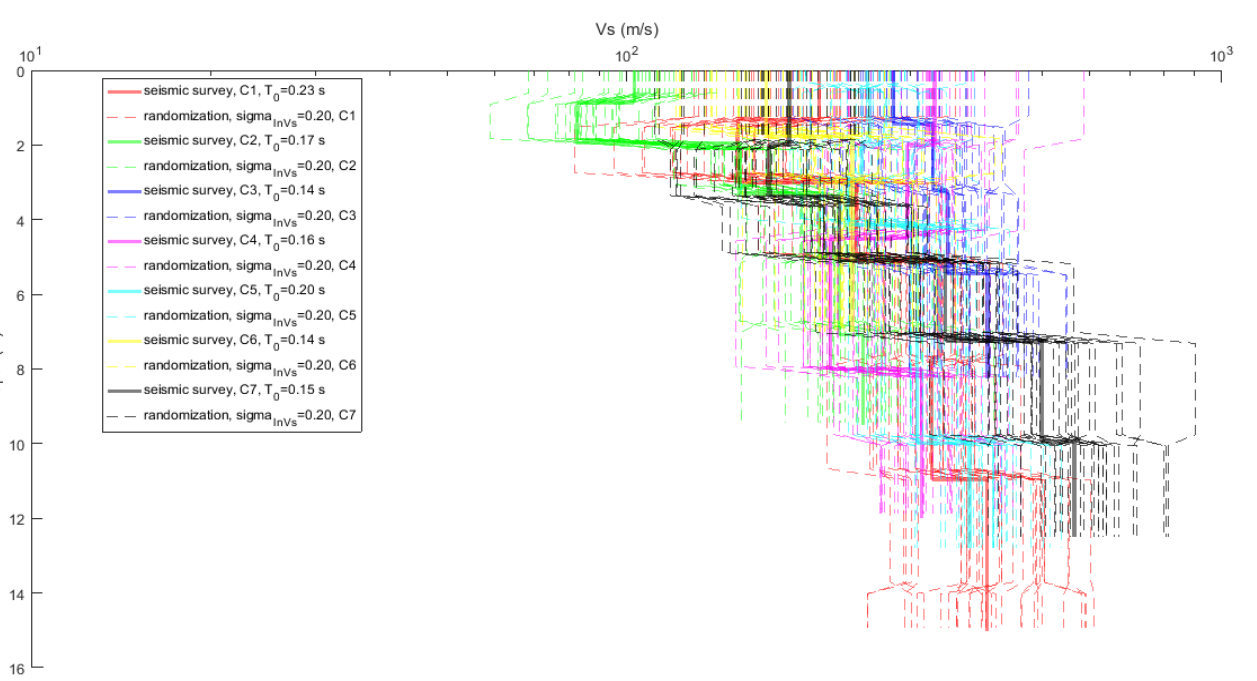
0 is the fundamental period of the